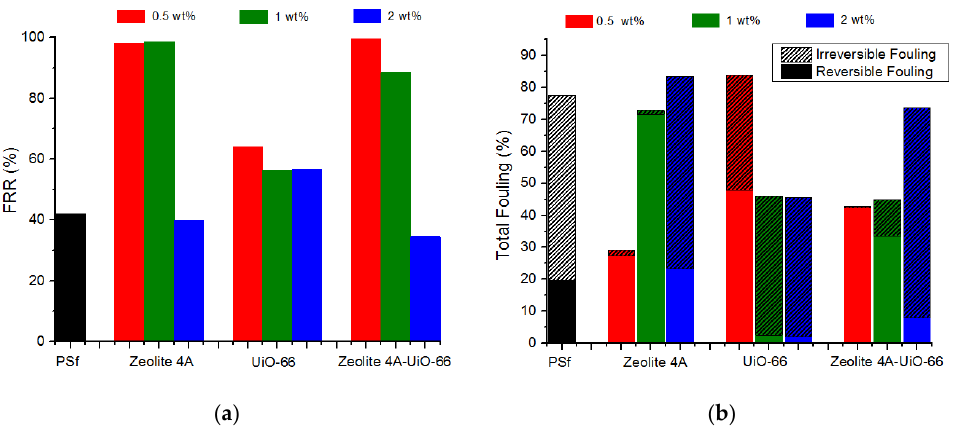
Figure 7. Fouling parameters of neat PSf and MMMs. ( a ) Flux Recovery Ratio of neat PSf and MMMs ( b ) Reversible, Irreversible and Total fouling of neat PSf and MMMs. PSf/UiO-66 (0.5 wt%) membrane possess FRR of 64% higher than neat PSf membrane due to